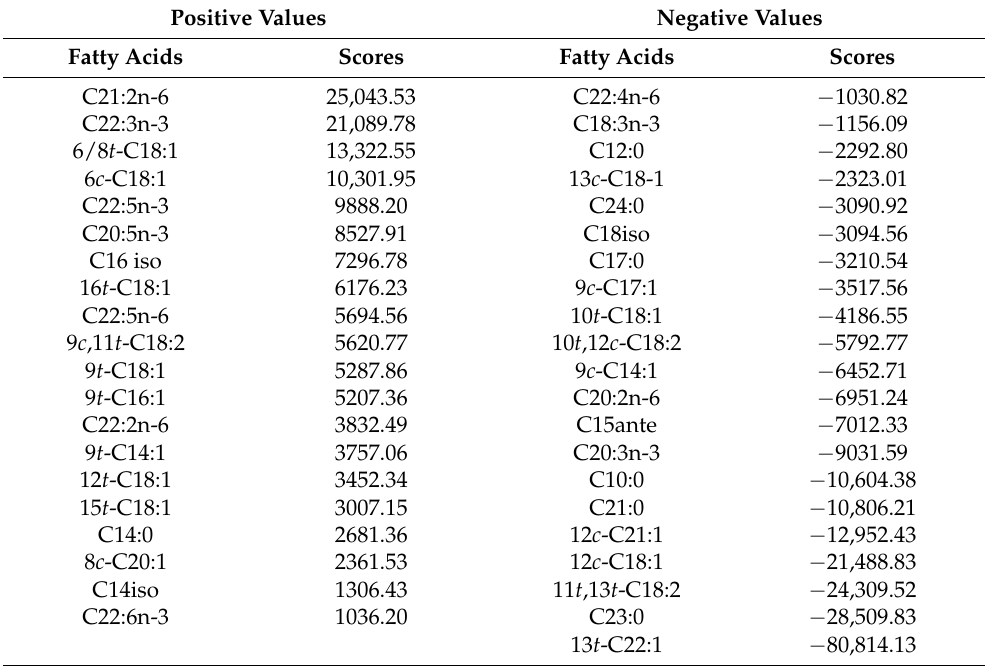
Table 7. Scores of canonical